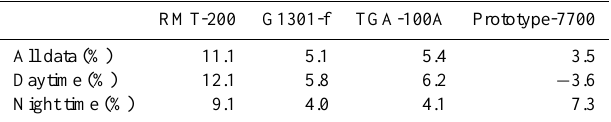
Fig. 7. Diurnal variations of RMT-200, G1301-f and Prototype- 7700 methane fluxes at different stages of post-processing. Dotted line represents diurnal variation of raw, uncorrected data. SC, WPL and SP correspond to spectral corrections, WPL terms and spectro- scopic correction, respectively. Therefore, black line shows the diur- nal variation of fully corrected, final flux. Diurnal variation of TGA- 100A methane flux is shown for comparison with red line. Only data between 17 April and 17 May were used. Flux data flagged with quality flag 0 was selected for all plots individually and thus the red lines are not exactly the same in these three figures. Table 3. Magnitude of spectral corrections given as percentages of raw uncorrected covariance. Positive and negative values mean that the correction increases upward and downward directed flux, re- spectively. Daytime was defined as periods when the Sun’s eleva- tion angle was above 0 ◦ and nighttime was defined as periods when it was below − 3 ◦ . Only data from a period when all the instruments were working (17 April–17 May) was used in calculating the values in the